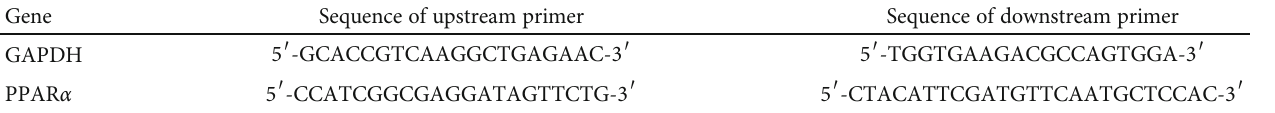
Table 2: Sequence of primers of GAPDH and PPAR α .